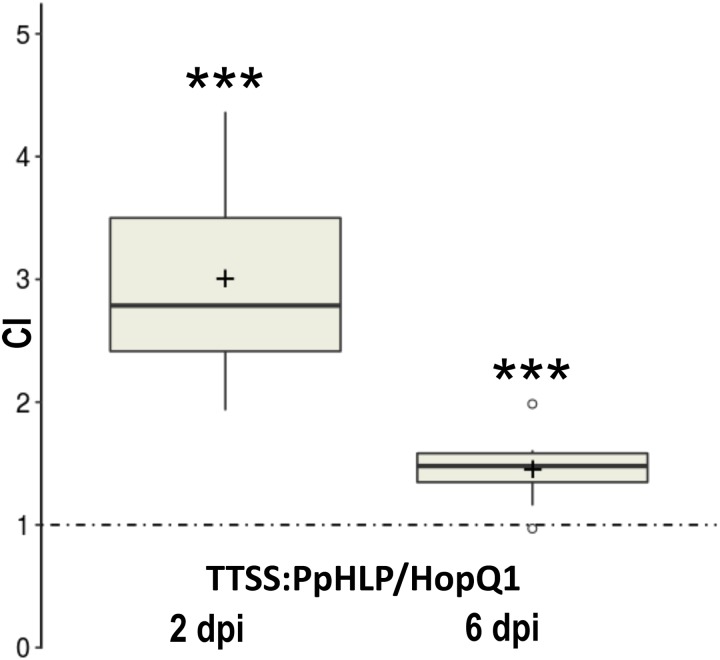
Assessment of virulence properties of TTSS-PpHLP. Bean leaves were inoculated with Pseudomonas syringae pv. tomato DC3000Δ28E (approximately 105 cfu mL-1) strains expressing HopQ1 or TTSS-PpHLP. Immediately prior to infiltration, bacteria were mixed in a 1:1 ratio. Two and 6 days post-inoculation (dpi), two leaf disks per plant were cut out from the infiltrated zones, ground in sterile 10 mm MgCl2, diluted, and plated on LB medium. Bacterial strains were distinguished by a selectable marker. The CI (competitive index) was calculated as the ratio of bacteria expressing TTSS-PpHLP to bacteria expressing wild-type HopQ1 isolated from plant leaf and normalized to the input titers of the bacteria. Asterisks indicate that the index is significantly different from 1, as established using Student’s t-test (P < 0.001). Pluses represent the means. The experiment was performed three times with similar results.